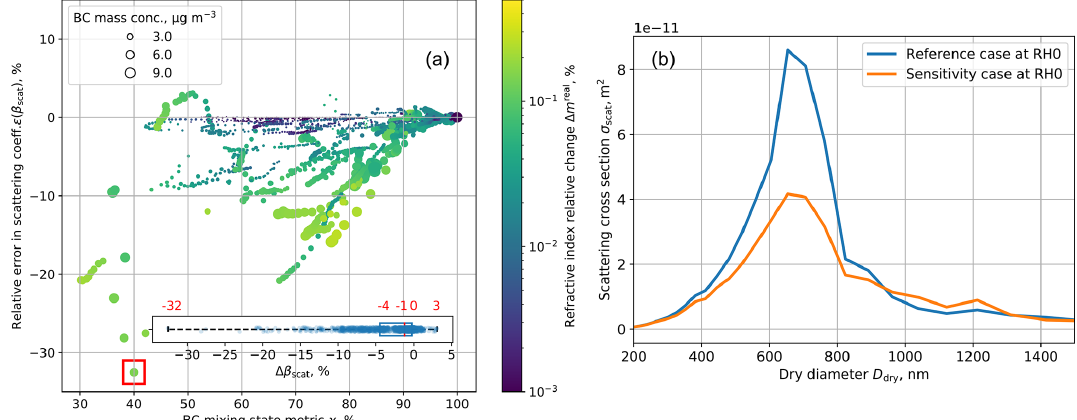
Figure 6. (a) Same as Fig. 4 but for (cid:15) ( β scat ). The color is for refractive index relative change, and the marker size represents BC bulk mass in the population. The red box is the population analyzed in (b) . (b) Size-resolved scattering coefficients for the reference and sensitivity (composition-averaged scenario library). The population is from scenario 77 at t = 2h.